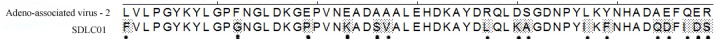
Sequence alignments of Parvovirus PLA2 Motifs and sPLA2 representatives between SDLC01 strain and Adeno-associated virus -2.